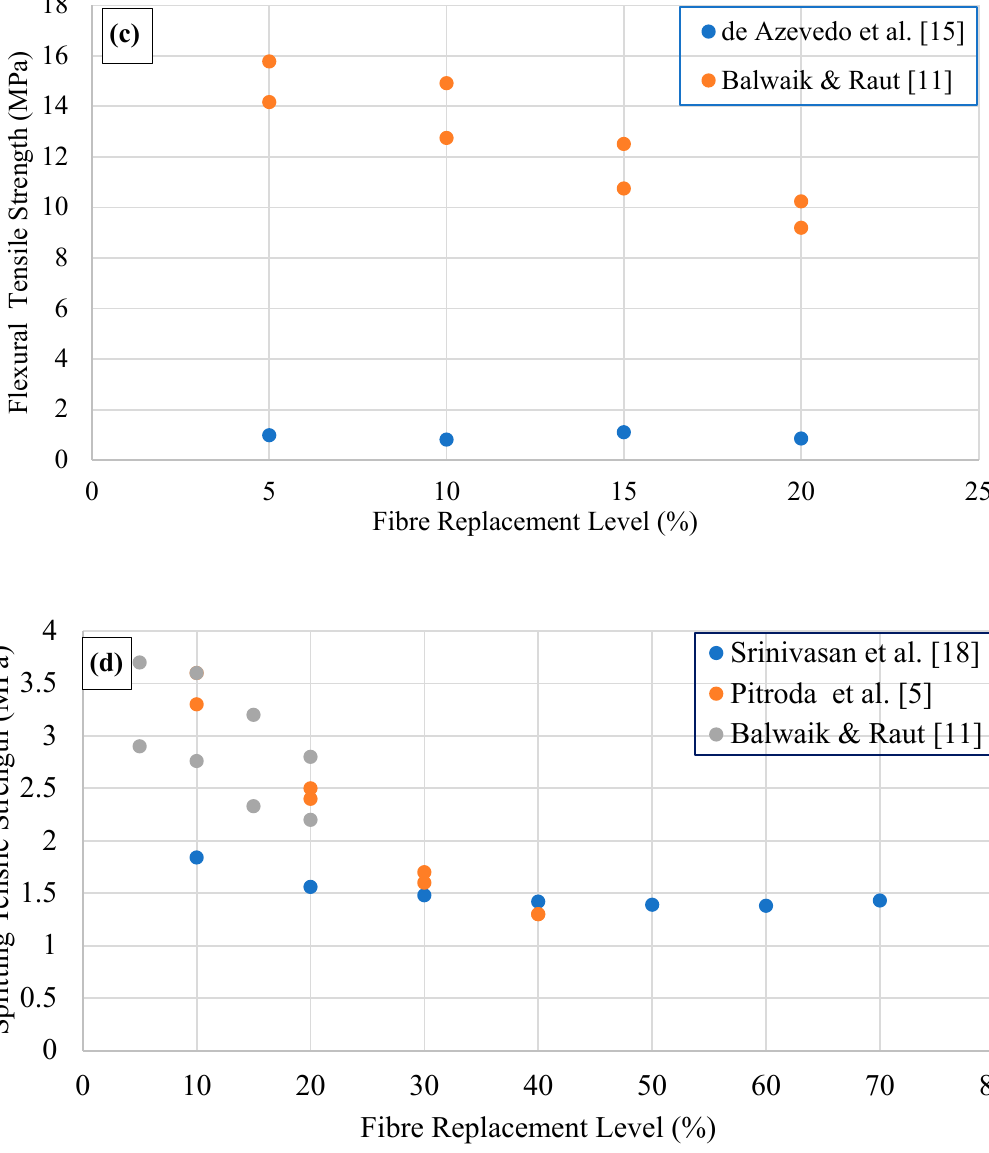
Figure 3. ( a ) Density; ( b ) 28-day compressive strength; ( c ) 28-day flexural tensile strength; and ( d ) 28-day splitting tensile strength variations of waste paper sludge cement composite binders.